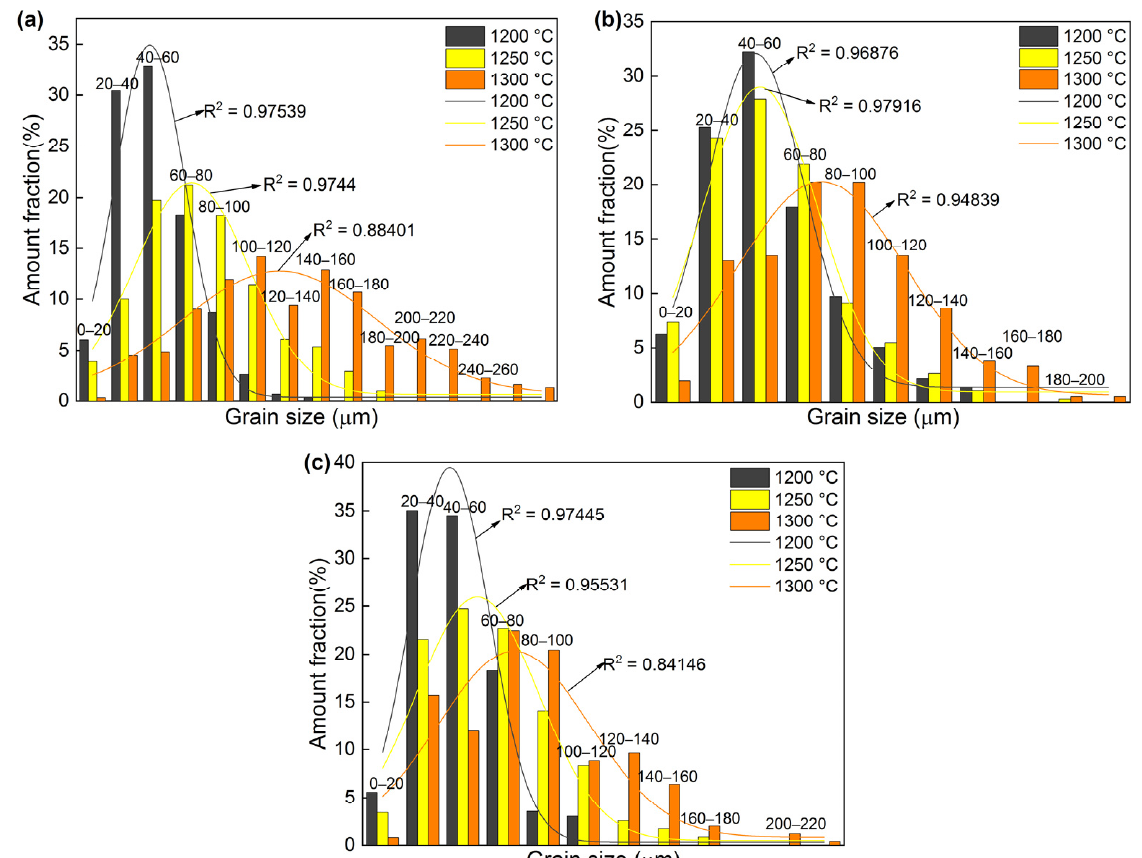
Figure 7. Grain distribution and normal fitting curves at different peak temperatures with the same t 8/5 time: ( a ) t 8/5 = 20 s, ( b ) t 8/5 = 50 s ( c ) t 8/5 = 100 s. t 8/5 time: ( a ) t 8/5 = 20 s, ( b ) t 8/5 = 50 s ( c ) t 8/5 = 100